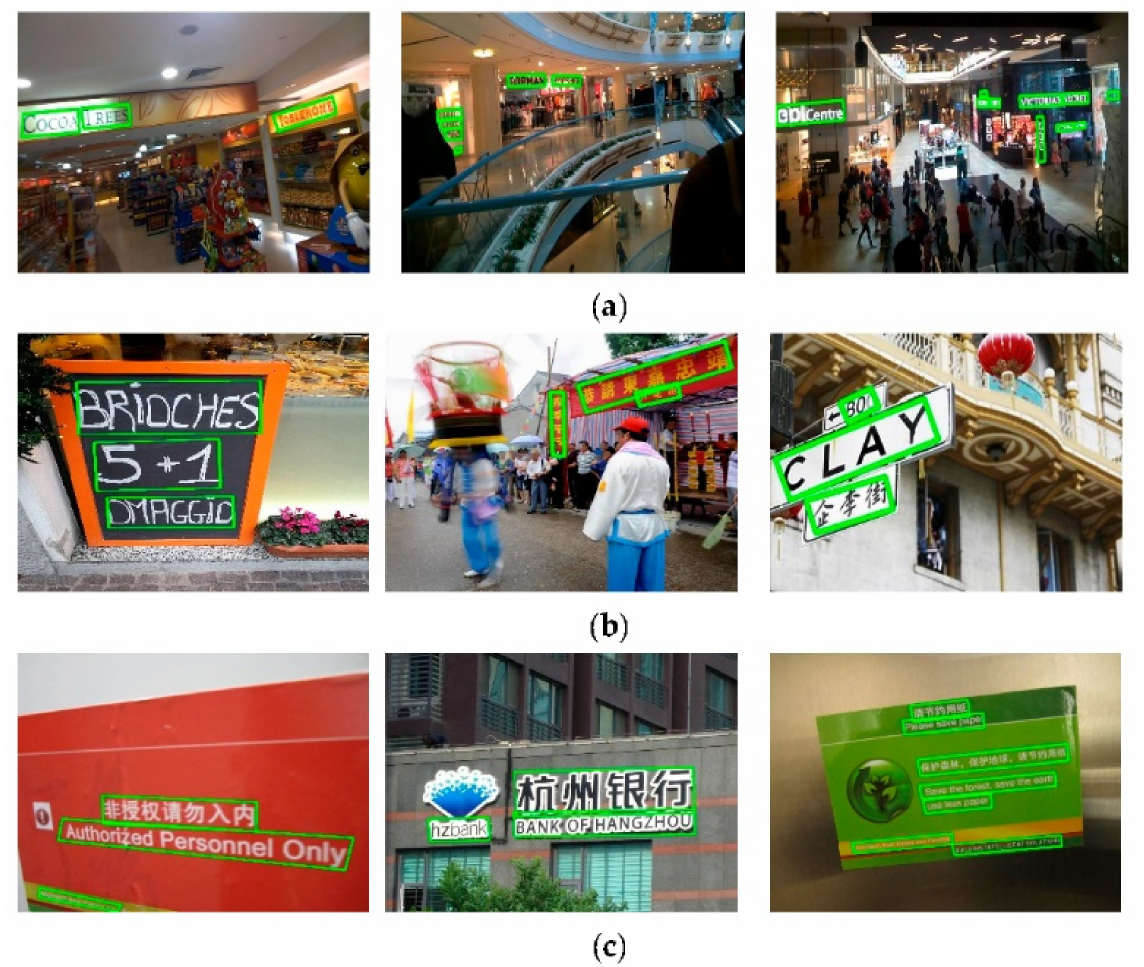
Figure 4. Some qualitative results of the proposed method on IC15 ( a ), IC17 ( b ), and TD500 ( c